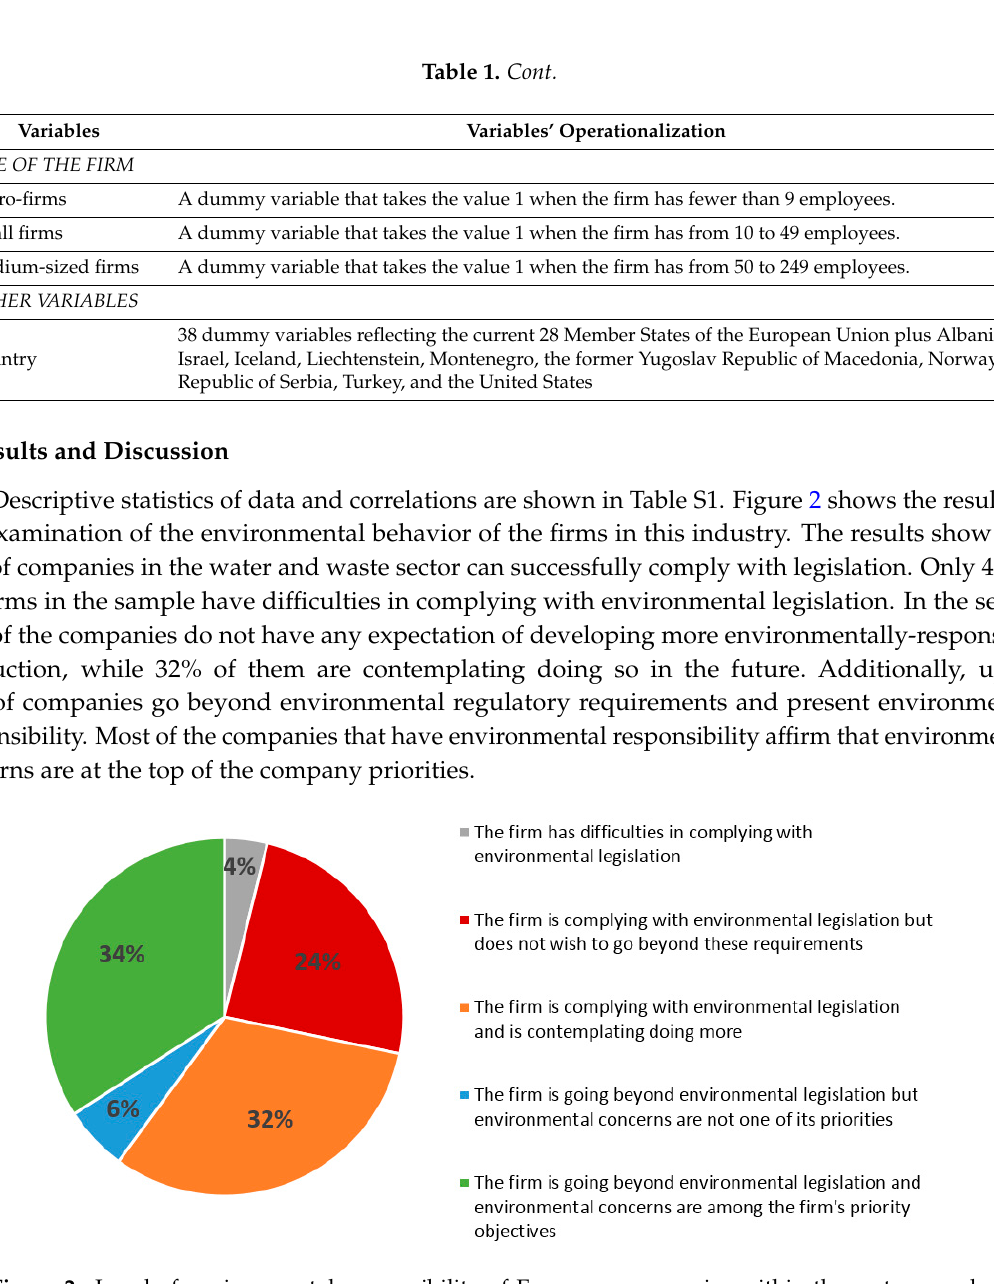
Figure 2. Level of environmental responsibility of European companies within the water supply, sewerage, waste management and remediation sector.